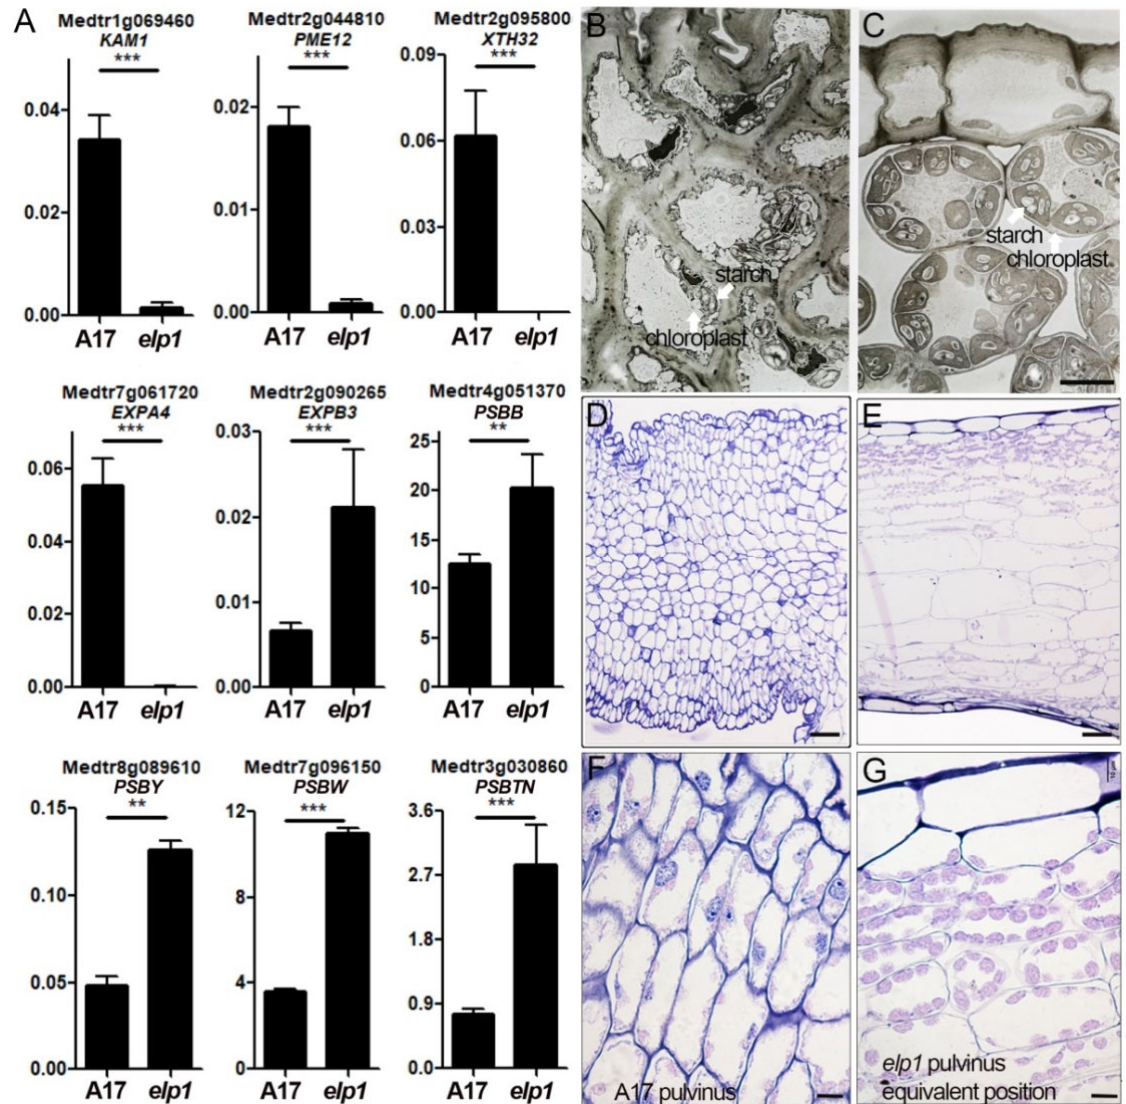
Figure 7. Both cell wall structure and chloroplasts distribution are altered in elp1 mutants. ( A ) RT-qPCR analysis of cell wall and photosynthesis-related gene transcription in pulvinus of WT and the equivalent position of elp1 mutants. Values shown in the form mean ± SD ( n = 3), and asterisks indicate a statistically significant difference between WT and elp1 mutants (**, p < 0.01; ***, p < 0.001; t -test). ( B , C ) Transmission electron microscopy images of a pulvinus of WT ( B ) and the equivalent position of elp1 mutants ( C ), respectively. Cell arrangement and cell wall structure show the significant difference between WT and elp1 mutants. ( D – G ) Semi-thin sections analysis of a pulvinus of WT ( D , F ) and the equivalent position of elp1 mutants ( E , G ). Scale bars, 5 µ m in ( B , C ), 50 µ m in ( D , E ), 10 µ m in ( F , G ).